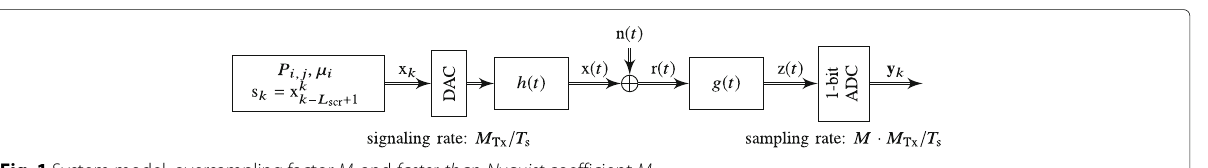
Fig. 1 System model, oversampling factor M , and faster-than-Nyquist coefficient M